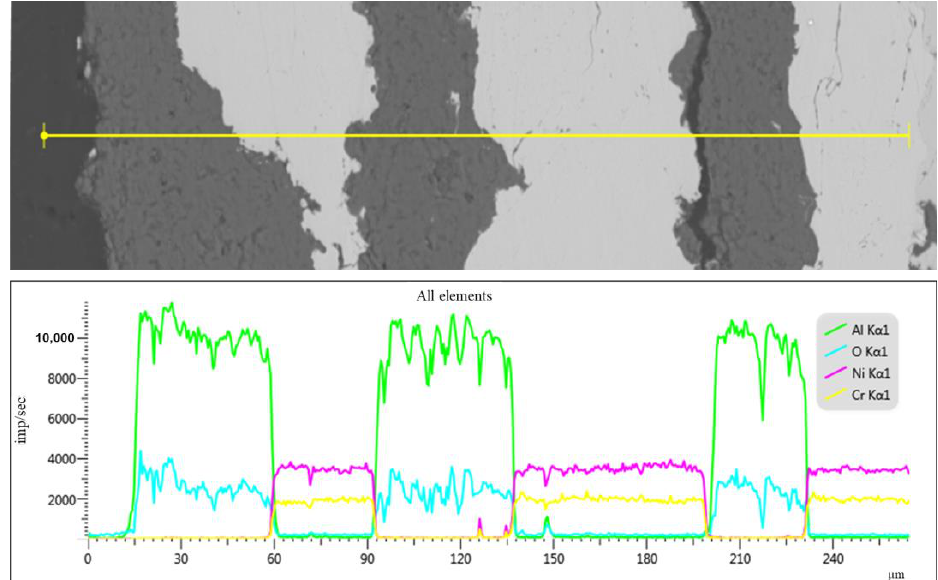
Figure 11. Distribution of elements along the cross-sectional line of the six-layer gradient coating.